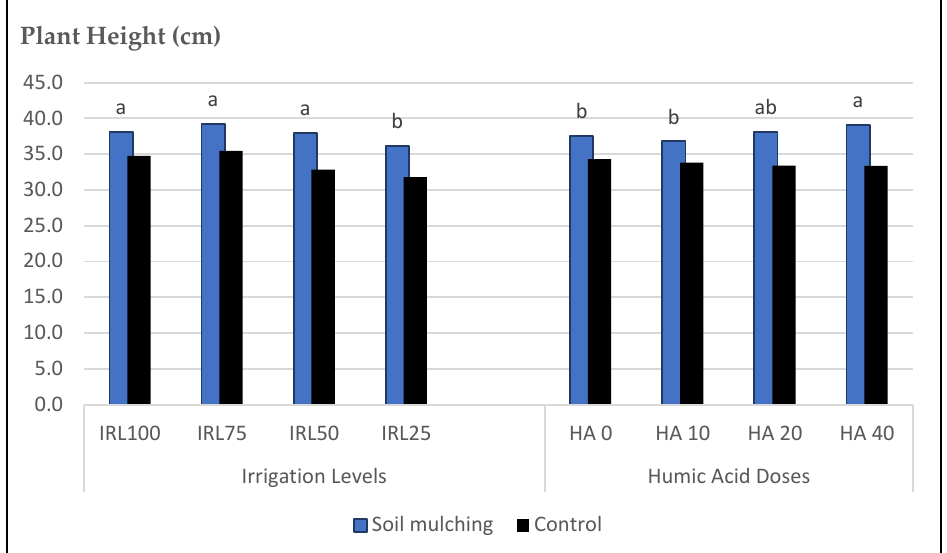
Figure 5. Mean values of PH of O. basilicum L. under soil mulching and control conditions. IRL 100 = 100% FC; IRL 75 = 75% FC; IRL 50 = 50% FC; IRL 25 = 25% FC; HA 0 = 0.0 Lha − 1 ; HA 10 = 10.0 Lha − 1 ; HA 20 = 20.0 Lha − 1 ; HA 40 = 40.0 Lha − 1 .